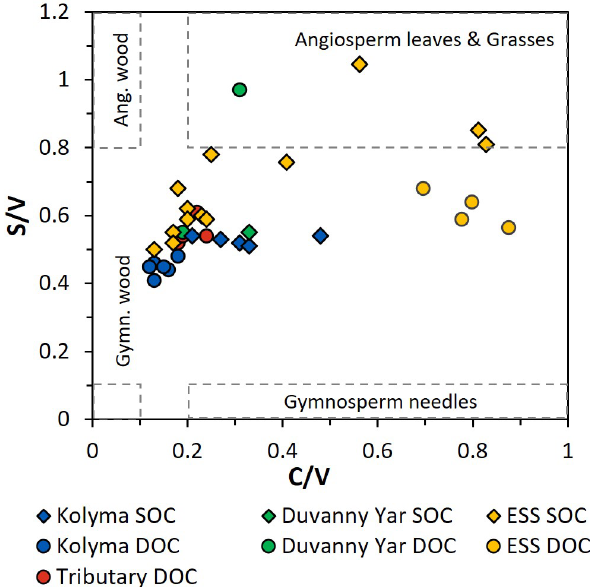
Figure 5. The ratios between syringyl / vanillyl (S / V) and cin- namyl / vanillyl (C / V) can be used as biomarker source proxies for sediment organic carbon (SOC; diamonds), dissolved organic carbon (DOC; circles) from the Kolyma River (blue), Duvanny Yar (green), East Siberian Sea (ESS; yellow) and a few smaller tribu- taries of the Kolyma (red). Ranges for vegetation and tissue types (boxes) are based on Goñi et al.